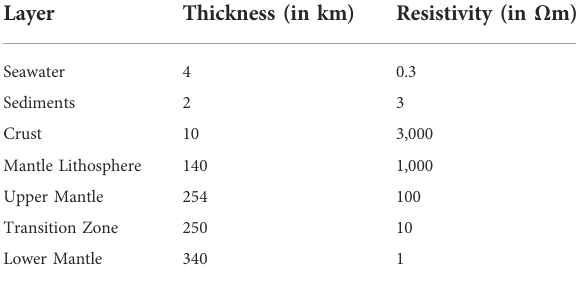
TABLE 2 Parameters for test Ocean-Earth model (Atlantic